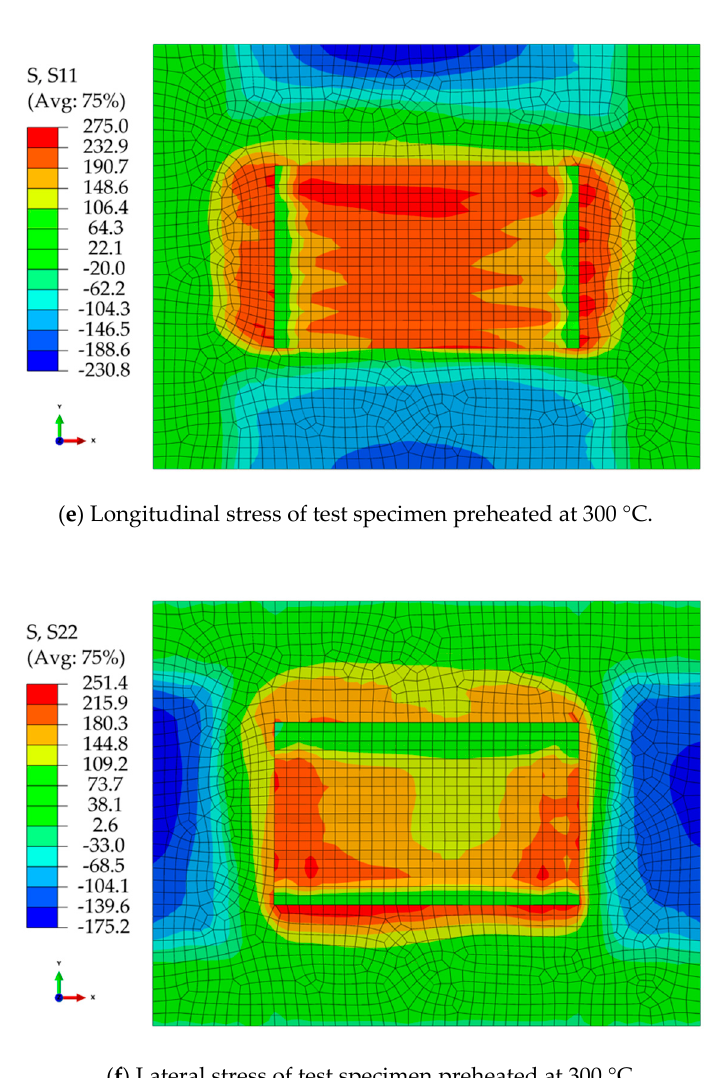
Figure 8. Residual stress field of different preheating temperature.